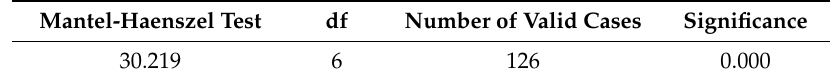
Table 3. Mantel–Haenszel test.